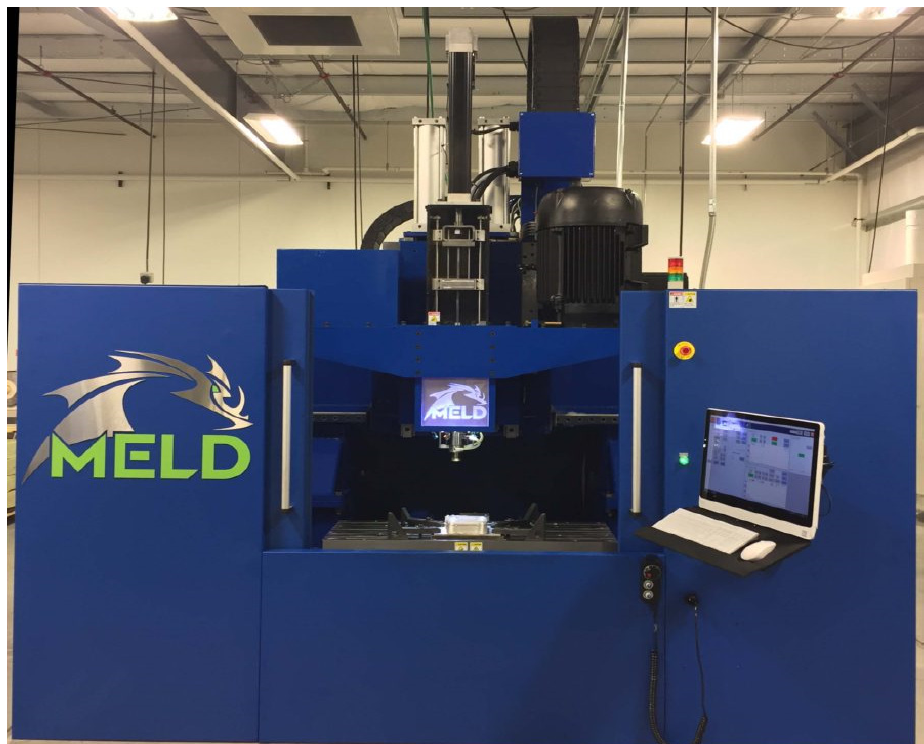
(Figure 2), including K2, L3, B8, and CD-14 systems. Corresponding advantages are shown in Table 1.